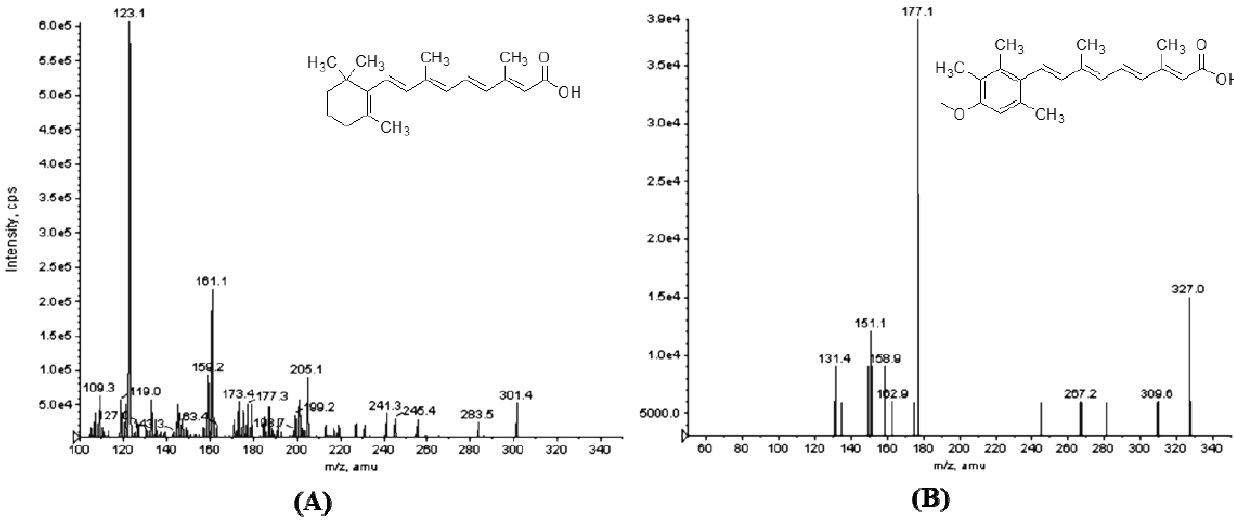
Figure 1. Product ion mass spectra of (A) ATRA ( m/z 301.4 → 123.1) and (B) acitretin (IS, m/z 326.9 → 177.1) in positive ionization